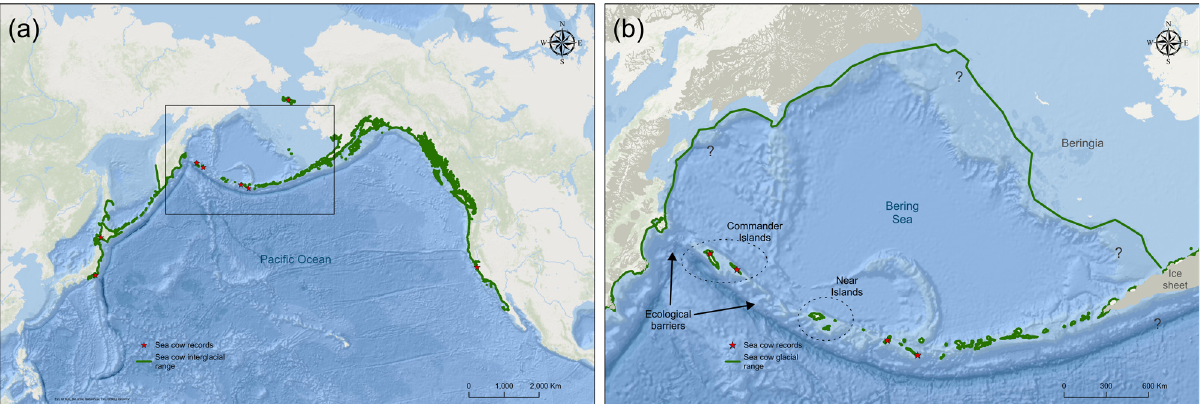
Fig. 1 Steller ’ s sea cow ( Hydrodamalis gigas ) range reconstructions. ( a ) Interglacial range. ( b ) Range during glacial maxima. The Commander Islands have always been physically isolated by deep channels - even during lowest sea levels - that likely constituted ecological barriers, or biogeographic breaks, for sea cows. Different lines of evidence (e.g., absence of echolocation or other navigational apparatus 13 ; limited ability to submerge 9 ; exclusive seaweed diet 10 ) converge to a strictly coastal, ‘ linear elongated ’ distribution along kelp-dominated shorelines, a range that coincided with that of the sea otter, Enhydra lutris 13 . Sea cow range reconstructions were based on: (1) review of existing sea cow records (see Dataset); (2) bioindicators of sea cow habitat (i.e., kelp forests, sea otter historical ranges 14 ); (3) southern extent of winter drift ice and year-round kelp habitat; 15,16 and (4) the estimated shoreline of Beringia and Bering Sea islands during the Last Glacial Maximum 12 . ‘ Sea cow records ’ (red stars) refer to undisputed records only. Question marks refer to uncertainties related to sea ice extent along the shoreline of Beringia during glacial times. Map background image source and license: Maps were created using ArcGIS Online basemap ‘ World Ocean Base ’ (Esri, GEBCO, DeLorne, NaturalVue) and using ArcGIS ® software by Esri. ArcGIS ® and ArcMap ™ are the intellectual property of Esri and are used herein under license. Copyright © Esri. All rights reserved. For more information about Esri ® software, please